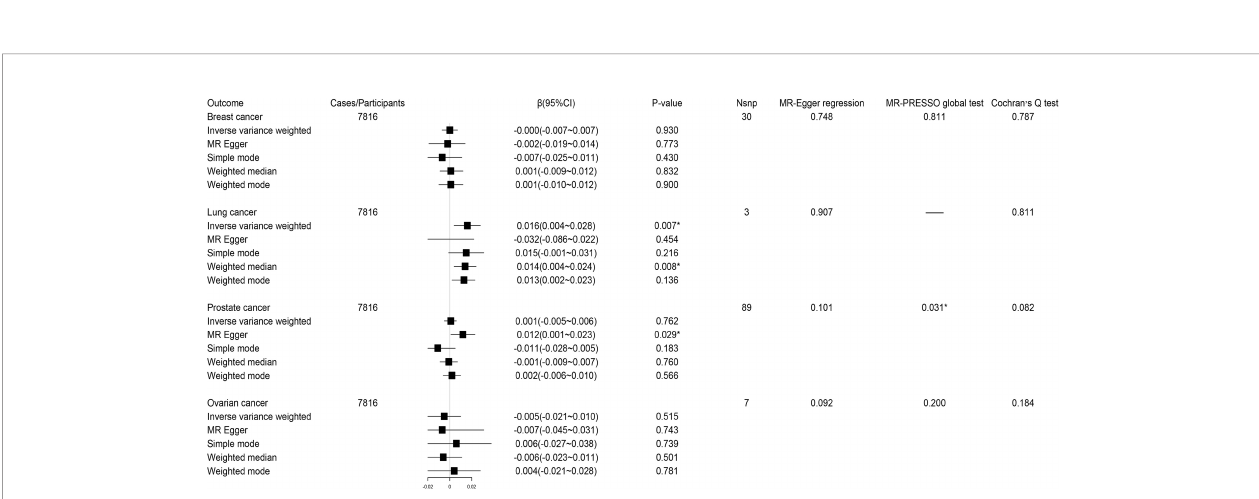
FIGURE 4 | Forest plot for associations between circulating kynurenine levels and the risk of site-speci fi c cancers. b , beta value; CI, con fi dence interval; Nsnp, number of the SNPs; *P < 0.05.